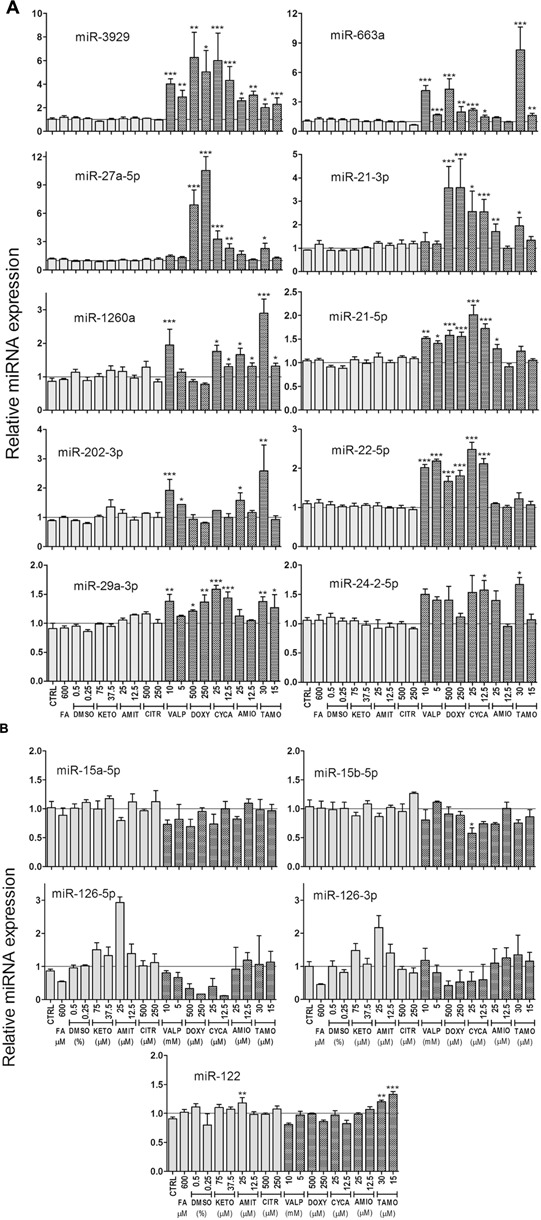
Expression level of selected miRNAs in cells treated with steatotic and non-steatotic drugs. Human HepG2 cells were incubated as explained in the legend to Figure 2. Steatotic drugs, but no FA, preferentially trigger miRNA induction (A). miR-15 and miR-126 were repressed by steatotic drugs, but miR-126 were also repressed by FA (B). The liver specific miR-122 did not respond to these drugs (B). Bars represent the mean ± SEM (n = 3–5). ∗p < 0.05, ∗∗p < 0.01, ∗∗∗p < 0.001, ANOVA, Tukey post hoc.